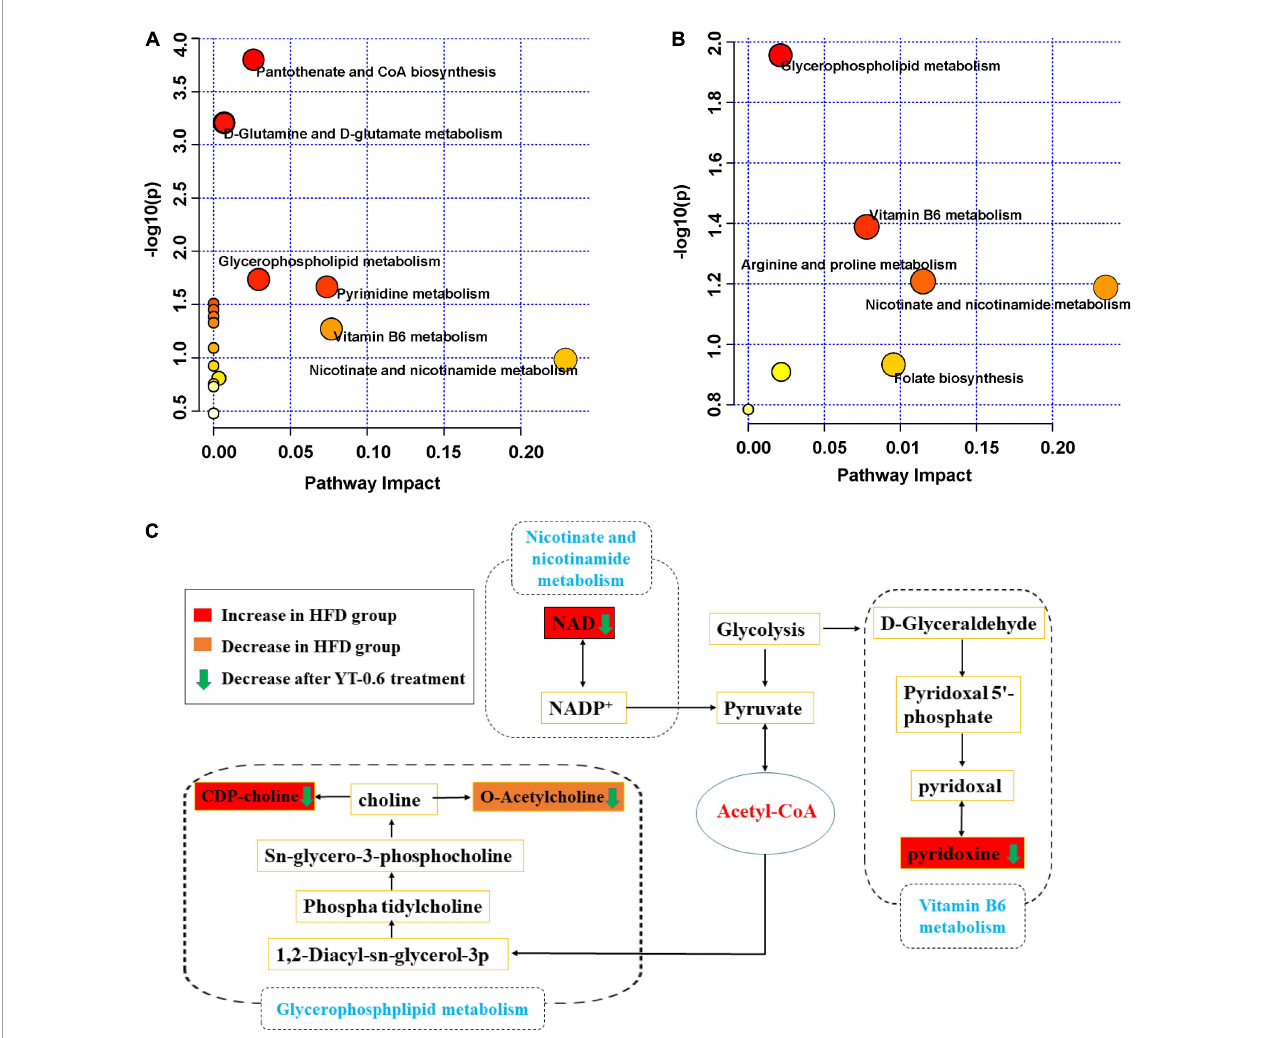
FIGURE6 Potential pathways related to the effect of YT extract on HFD diet-induced mice. (A) Disturbed metabolic pathways in the control vs. HFD-fed groups. (B) Disturbed metabolic pathways in the HFD-fed vs. YT-0.6 g/kg groups. (C) Metabolic network of the significantly altered metabolites associated with YT extract